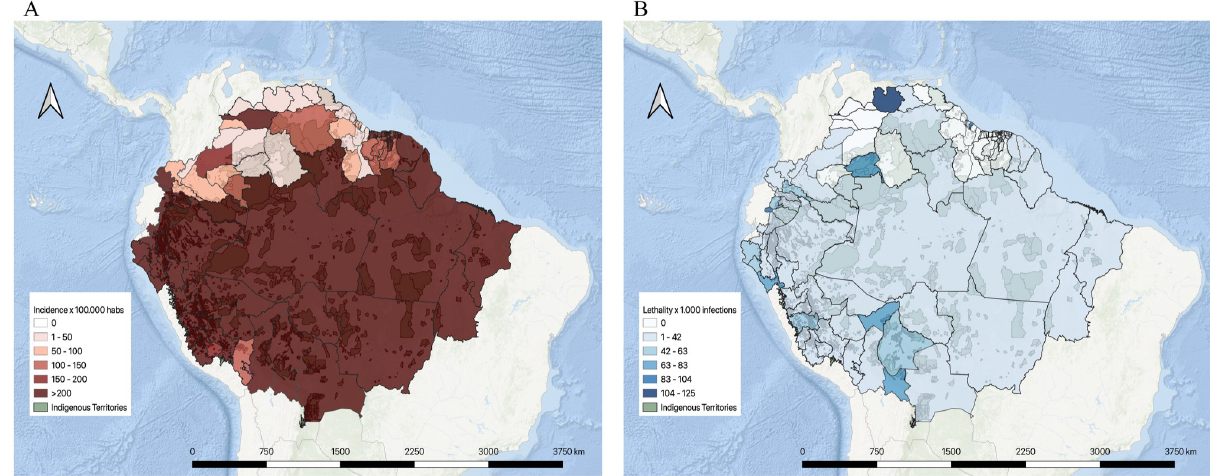
Fig 1. COVID-19 in the Amazonia: infected and deceased. (A) Incidence [29] in cases per 100,000 people is shown in a spectrum of white (zero incidence) to dark red (more than 200 cases per 100,000). (B) Lethality [29] rates per 1,000 infections is shown in a spectrum of white (zero deaths) to dark blue (104 to 125 deaths). The Indigenous territories are indicated in light green. [30] The map was created with the QGIS software (https://www. qgis.org/es/site/).